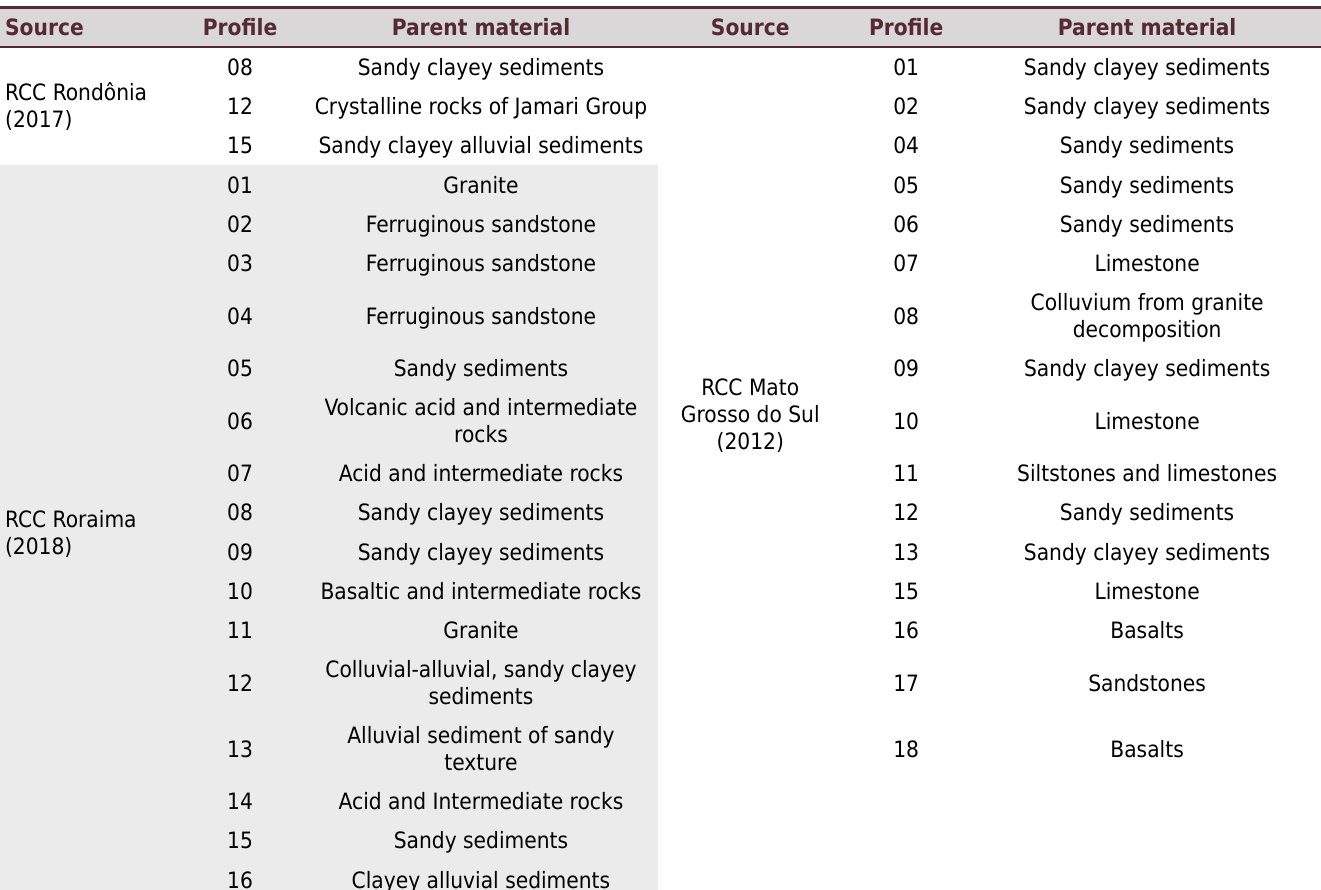
Table 1. Soil profiles number and parent material of each data reference source